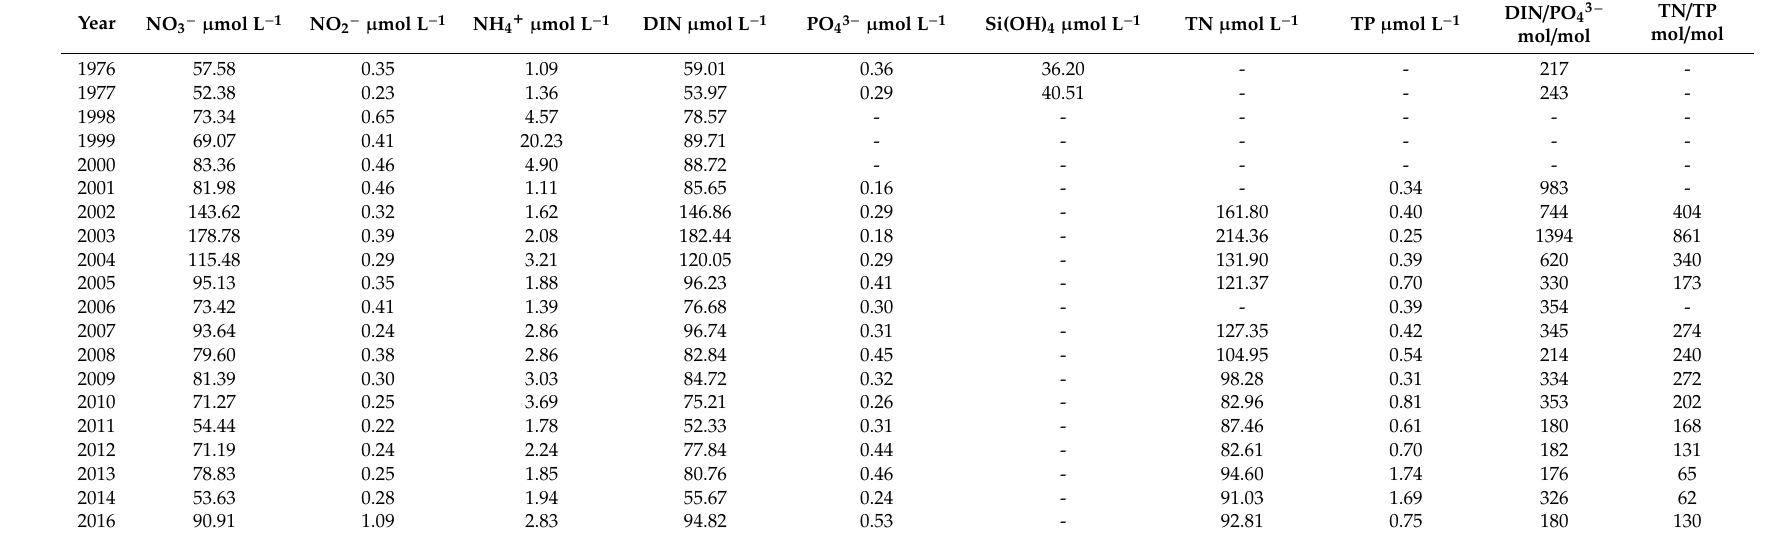
Table A1. Mean concentration of the nutrients ( µ mol L − 1 ) and molar nutrient ratios at the mouth of the Isonzo River (Pieris Stations) shown in Figure 6.